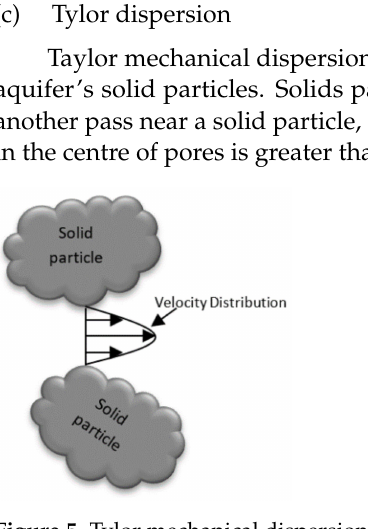
Figure 5. Tylor mechanical